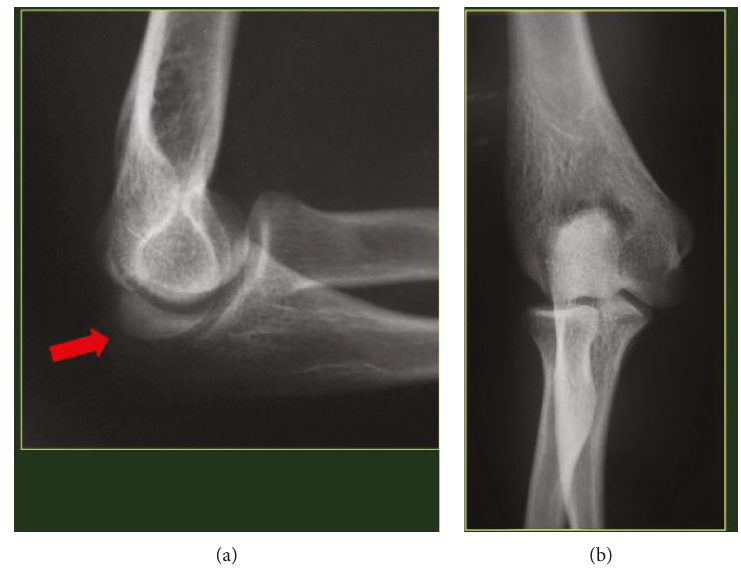
Figure 4: Case 2. (a, b) L and AP preoperative